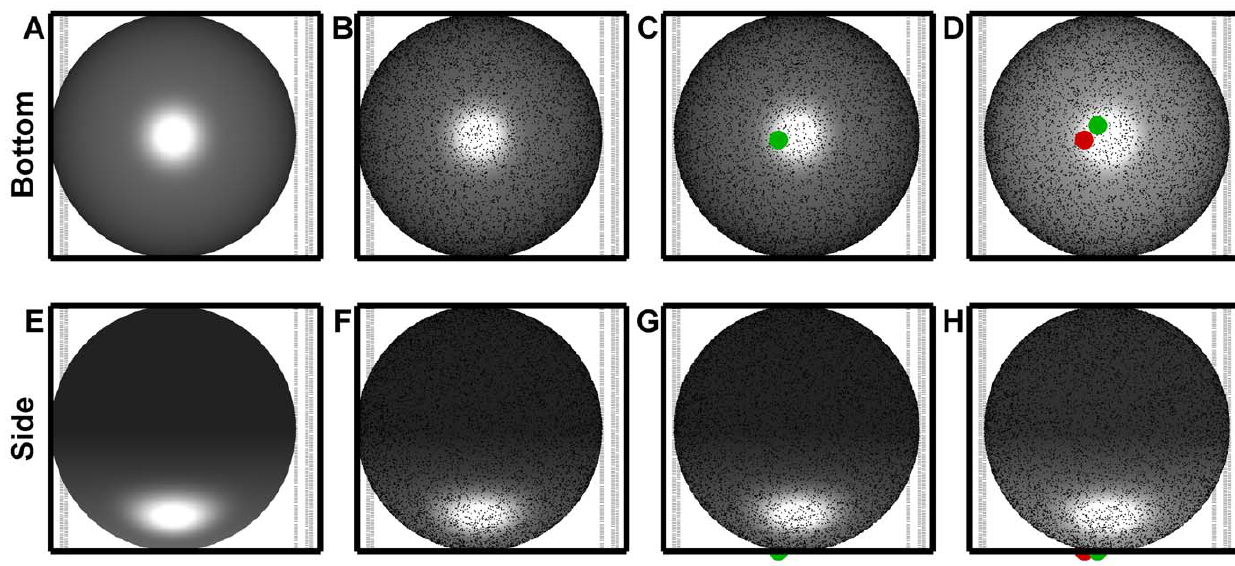
Figure 2. Iterative calculations in the simulation. (A,E) An initial gap size, generally small compared to the sphere’s radius, was randomly selected from the governing equilibrium distribution. (B,F) Receptors were randomly distributed over the surface. Fluid flow was started. Forces and torques were calculated, a diffusive component was added, the new sphere position and rotation was calculated, and receptors were tested for bond formation. (C,G) The sphere was translated and rotated into the new position. One bond formed in the calculation from the previous step. New force calculations on the bonds and sphere were performed. The bond’s green color indicates the sphere had not yet moved enough to begin mechanically stressing the bond. The new sphere position and rotation was calculated based on the forces and toques plus the diffusive component, then free receptors were tested for formation, and the existing bond was tested for breakage with the current position. (D,H) The sphere was translated and rotated into the new position. The brighter sphere coloring indicates the sphere moved closer to the ligand-coated surface. Vertical motion was significant compared to the length of a bond. The bond from the previous step was still present, and a new bond formed. If the new bond were to survive until it became stressed, it would exert a force perpendicular to the flow direction that will cause the sphere to wobble because it is off the sphere’s center line. Force calculations on the bonds and sphere were performed. The red color indicates the trailing bond was stressed and exerted forces and torques on the sphere. Next, the diffusive component would be added to the forces and torques on the sphere, the new sphere position and rotation would be calculated, then free receptors would be tested for formation and the existing bonds would be tested for breakage. The position would be updated and the calculation